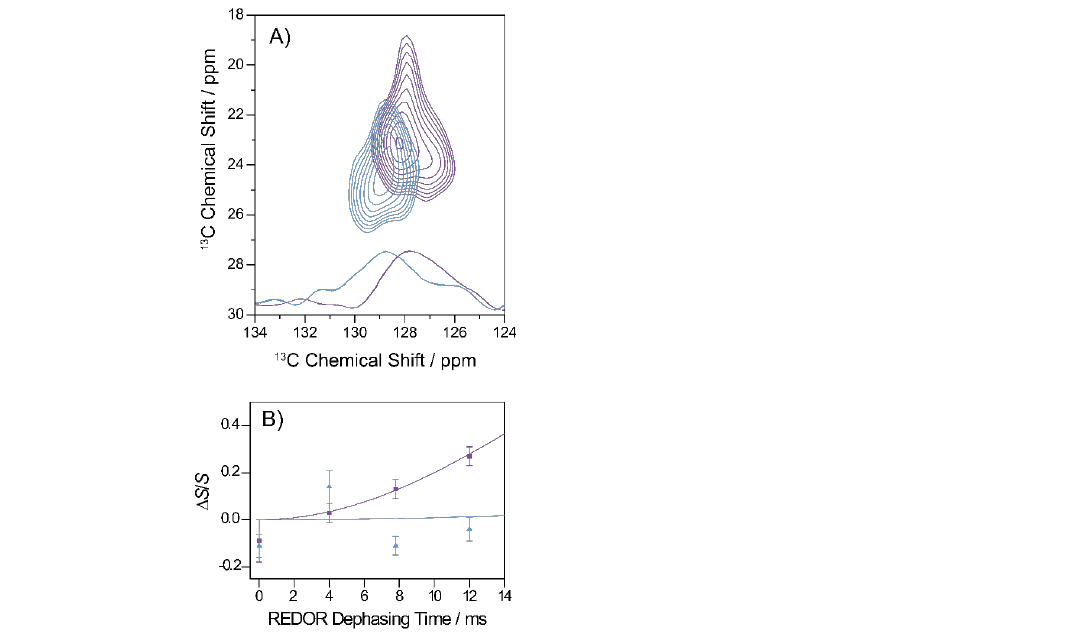
Figure 7. Summary of the specific tertiary contact analyses on Gly 33 Ala oligomers and fibrils. ( A ) Segment of the 13 C- 13 C DARR correlation spectra (500 ms mixing time) of oligomers (blue) and fibrils (violet). The cross peaks indicate a molecular contact between Phe 19 and Leu 34 in oligomeric and fibrillary state. Rows extracted from the 2D contour maps (at 23.1 ppm for fibrils in violet and at 24.5 ppm for the oligomers in blue) are plotted on the bottom of the graph. ( B ) REDOR dephasing curve of the Gly 33 Ala fibrils (violet) and oligomers (blue). The Asp 23 - 13 COO − -Lys 28 - 15 NH 3+ distance in the side chains of fibrils could be determined to 4.1 Å, indicating the formation of a stable salt bridge. In oligomers, no REDOR dephasing was observed between the side chains of Asp 23 and Lys 28 indicating the absence of the salt bridge.